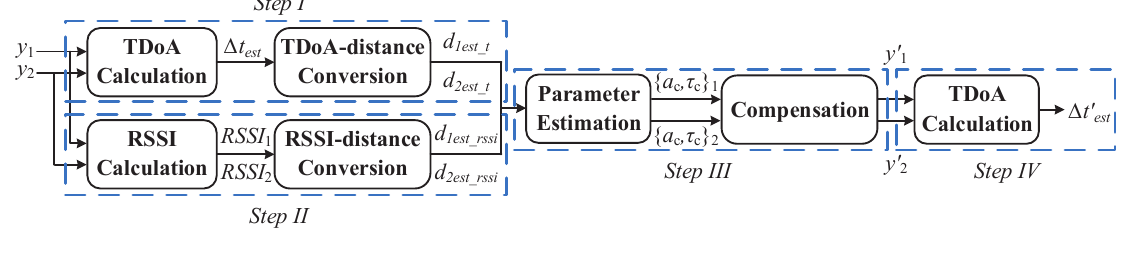
Figure 6. Processing flowchart of the proposed RSSI-assisted TDoA